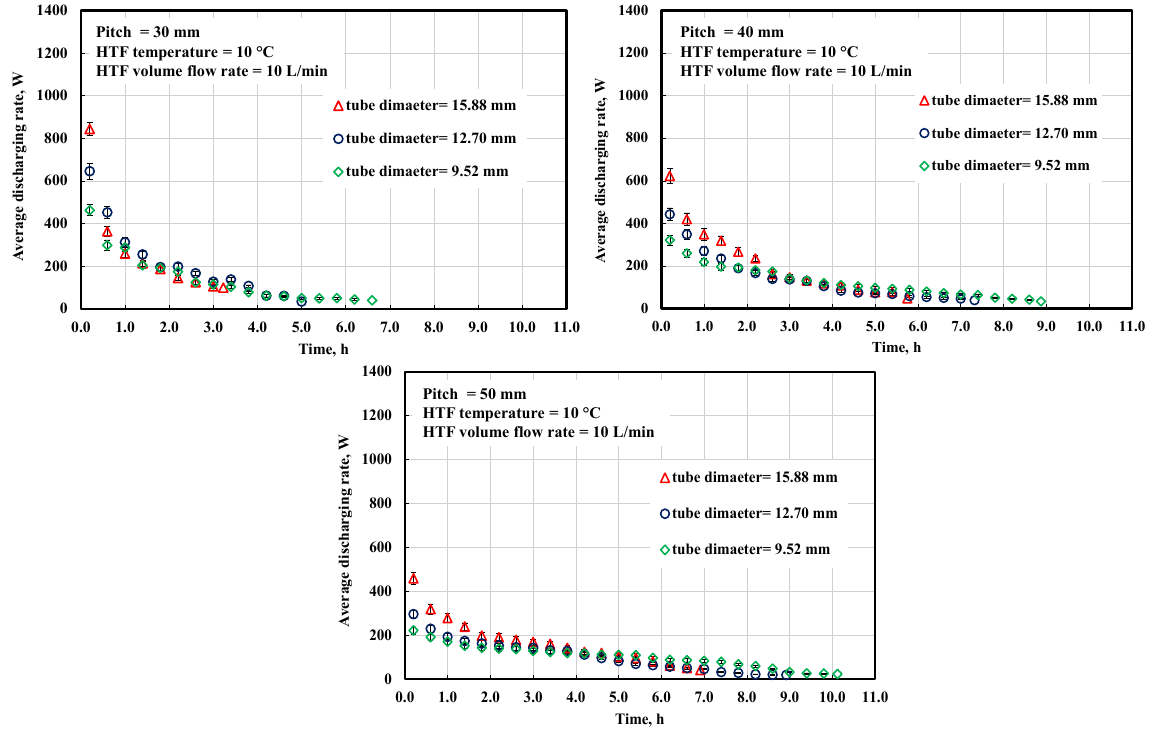
Figure 10. Average discharging rate versus time using various tube diameters with different pitches during the discharging process.